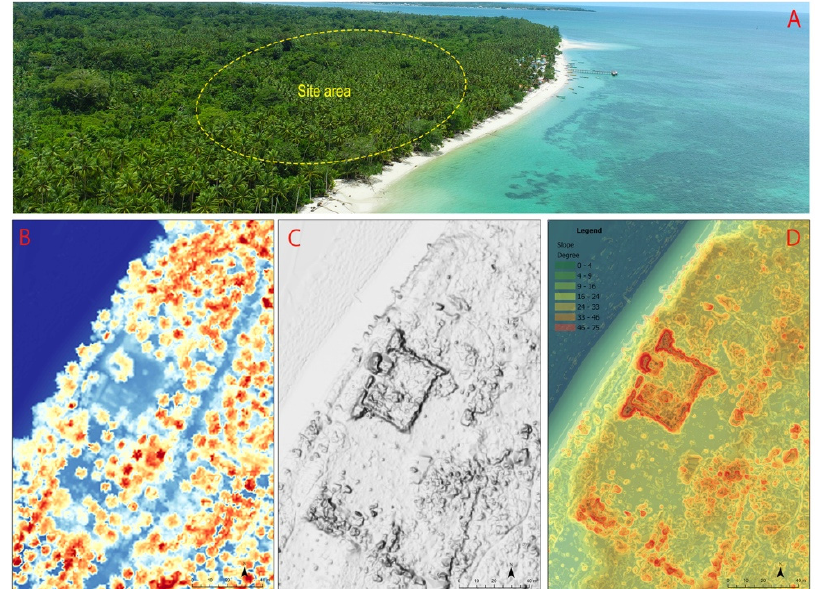
Figure 4. Remains of a 17th century CE Dutch settlement located using drone LiDAR at Kota Lama, Pulau Wokam, Aru, Maluka, Indonesia. Data captured with a Matrice 300 RTK drone with L1 LiDAR sensor payload. Images processed using DJI Terra and ArcGIS Pro. Panel ( A ) Drone photo showing site covered in dense vegetation. Panel ( B ) Digital Surface Model (DSM) generated by interpolating points acquired by the L1 sensor. Panel ( C ) Hillshaded Digital Elevation Model (DEM) interpolated from ground points following point cloud classification. Panel ( D ) Slope map showing the topographical variation in the DEM—slope values in degrees.